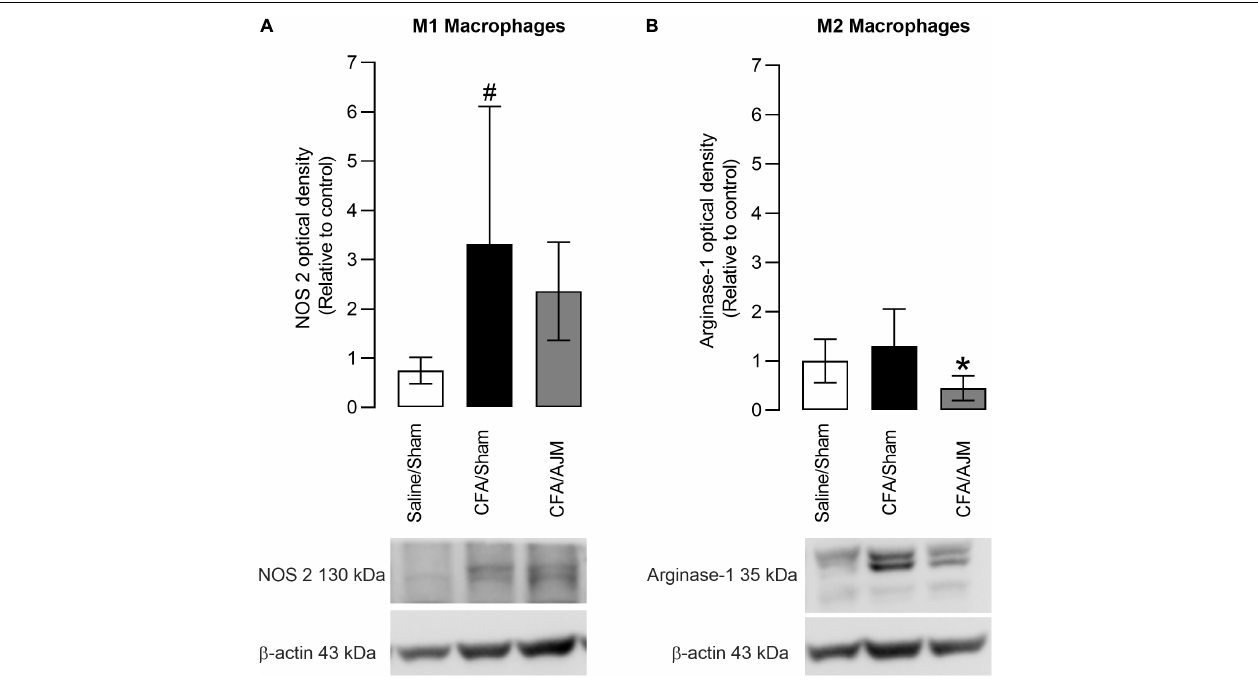
FIGURE 4 | Effects of AJM on the immunocontent of M1 (NOS 2) (A) and M2 (Arginase-1) (B) macrophage markers in the paw of male Swiss mice 98 h after intraplantar CFA-induced inflammation. Data are expressed as mean ± SD of 7 animals per group, statistically assessed by one-way ANOVA followed by Tukey’s post hoc test. # p < 0.05 when compared to the Saline/Sham group. * p < 0.05, when compared to the CFA/Sham group. CFA, Complete Freund’s Adjuvant; AJM, Ankle Joint Mobilization.